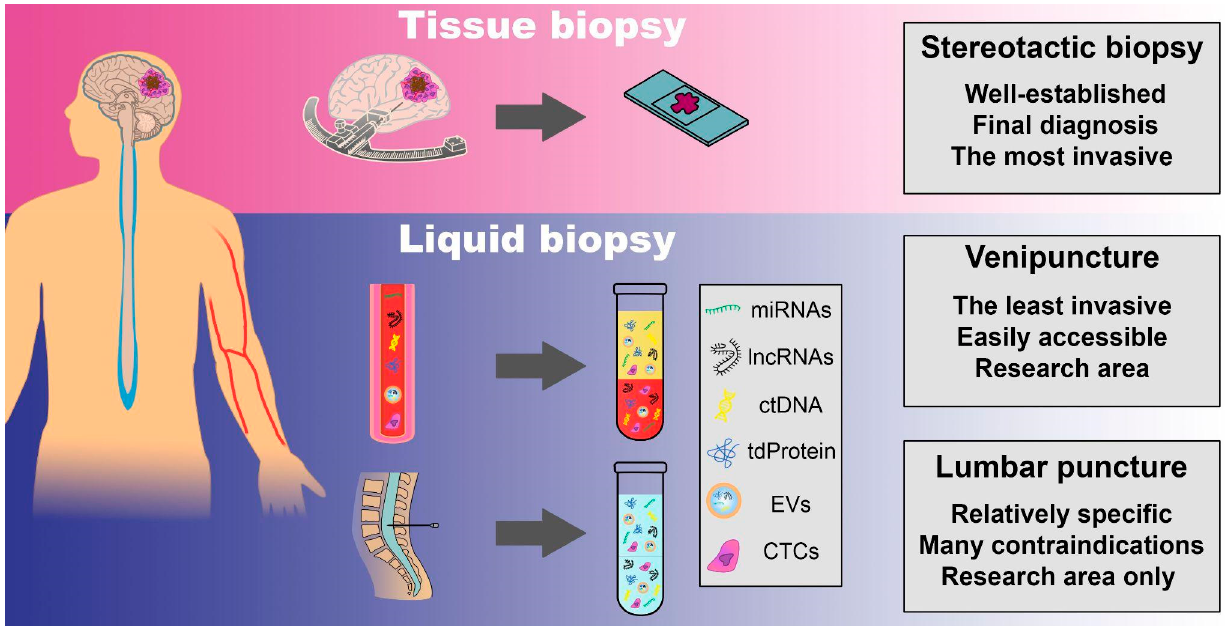
Figure 2. Obtaining the material to analyze biomarkers in glioma patients. The material can be obtained using tissue biopsy or liquid biopsies. A stereotactic biopsy is a well-established surgical procedure used to acquire tissue samples. Venipuncture and lumbar puncture are methods to obtain liquid biopsies. Circulating tumor cells (CTCs), extracellular vesicles (EVs), tumor-derived proteins (dtProteins), circulating tumor DNA (ctDNA), long non-coding RNAs (lncRNAs) and microRNA (miRNAs) are released into the bloodstream and cerebrospinal fluid (CSF) from primary tumors and metastatic deposits. Material collected by venipuncture, the least invasive technique, can be extracted, and plasma or serum can then be analyzed. The evaluation of circulating biomarkers in CSF is a relatively specific method, however it has many contraindications and currently remains only in the research area.